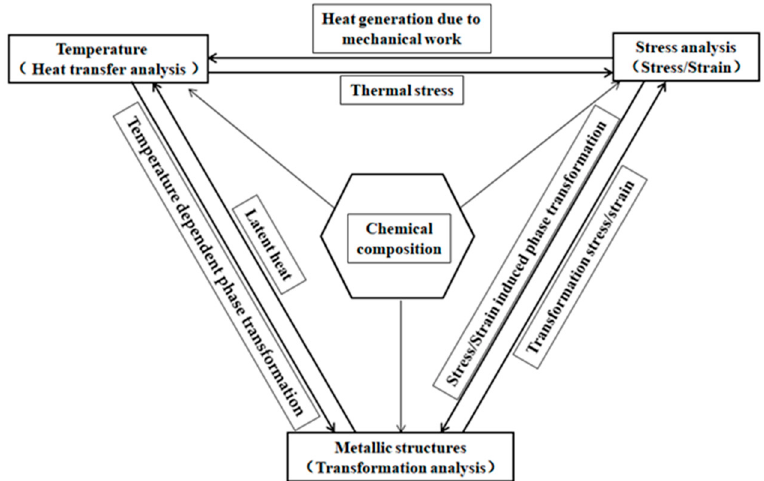
Figure 1. Metallo-thermal-mechanical theory in heat treatment processes.